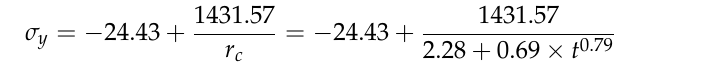
Figure 6. Schematic diagram of the interaction between the dislocation and the Cottrell atmosphere.